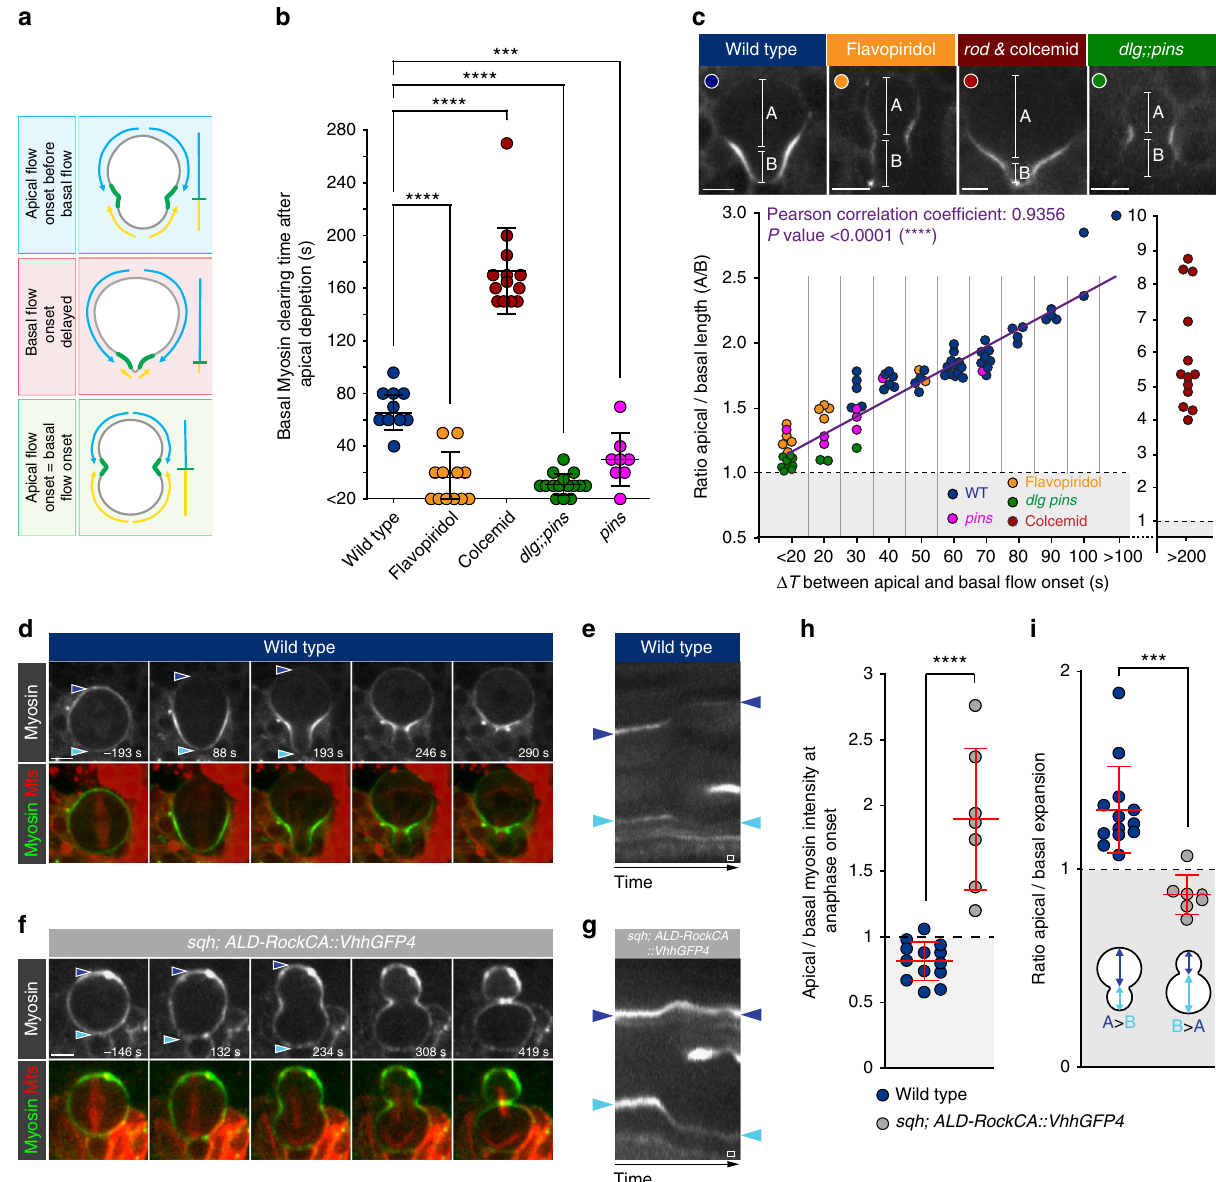
Fig. 7 Myosin fl ows are instrumental in establishing sibling cell size asymmetry. a Schematic illustration of the model to be tested: if cleavage furrow positioning and thus physical asymmetry depends on Myosin fl ows, then altering Myosin fl ow onset on the apical and/or basal cortex will misposition the cleavage furrow. b Scatter plot showing basal Myosin clearing time in relation to apical Myosin relocalization in wild-type, neuroblasts exposed to Flavopiridol or colcemid, dlg;;pins and pins mutants. c Scatter plot showing the correlation between Myosin clearing on the apical and basal cortex and the asymmetry of the division in anaphase. A Pearson coef fi cient of “ 1 ” indicates a perfect correlation between Myosin clearing and furrow positioning. d Representative image sequence and ( e ) kymograph showing a wild-type neuroblast (endogenous untagged Sqh still present) expressing Sqh::GFP (Myosin, white; top row, green; bottom row) and Cherry::Jupiter (MTs; red; bottom row). f Representative image sequence and g kymograph of a sqh mutant neuroblast, coexpressing Sqh::GFP and ALD-Rock CA ::VhhGFP4, a fusion between the single-chain GFP antibody (VhhGFP4), Inscuteable ’ s apical localization domain (ALD) and Rho kinase ’ s kinase domain. h Kymographs were used to calculate apical/basal Myosin intensity ratios and ( i ) apical and basal cortical expansions. The resulting ratios are represented as a scatter plot. Center values and error bars represent the mean and standard deviation (s. d), respectively. Asterisks denote statistical signi fi cance, derived from unpaired t-tests: * p ≤ 0.05, ** p ≤ 0.01, *** p ≤ 0.001, **** p ≤ 0.0001. Each measured cell (n) is represented with a dot in the scatter plots. For each experiment, the data were collected from at least 3 independent experiments. For each independent experiment, at least 5 larvae were dissected. Time: seconds (s). Scale bar: 5 µ m. Time scale bar (open white box) in ( e , g ): 58 s. n.s.